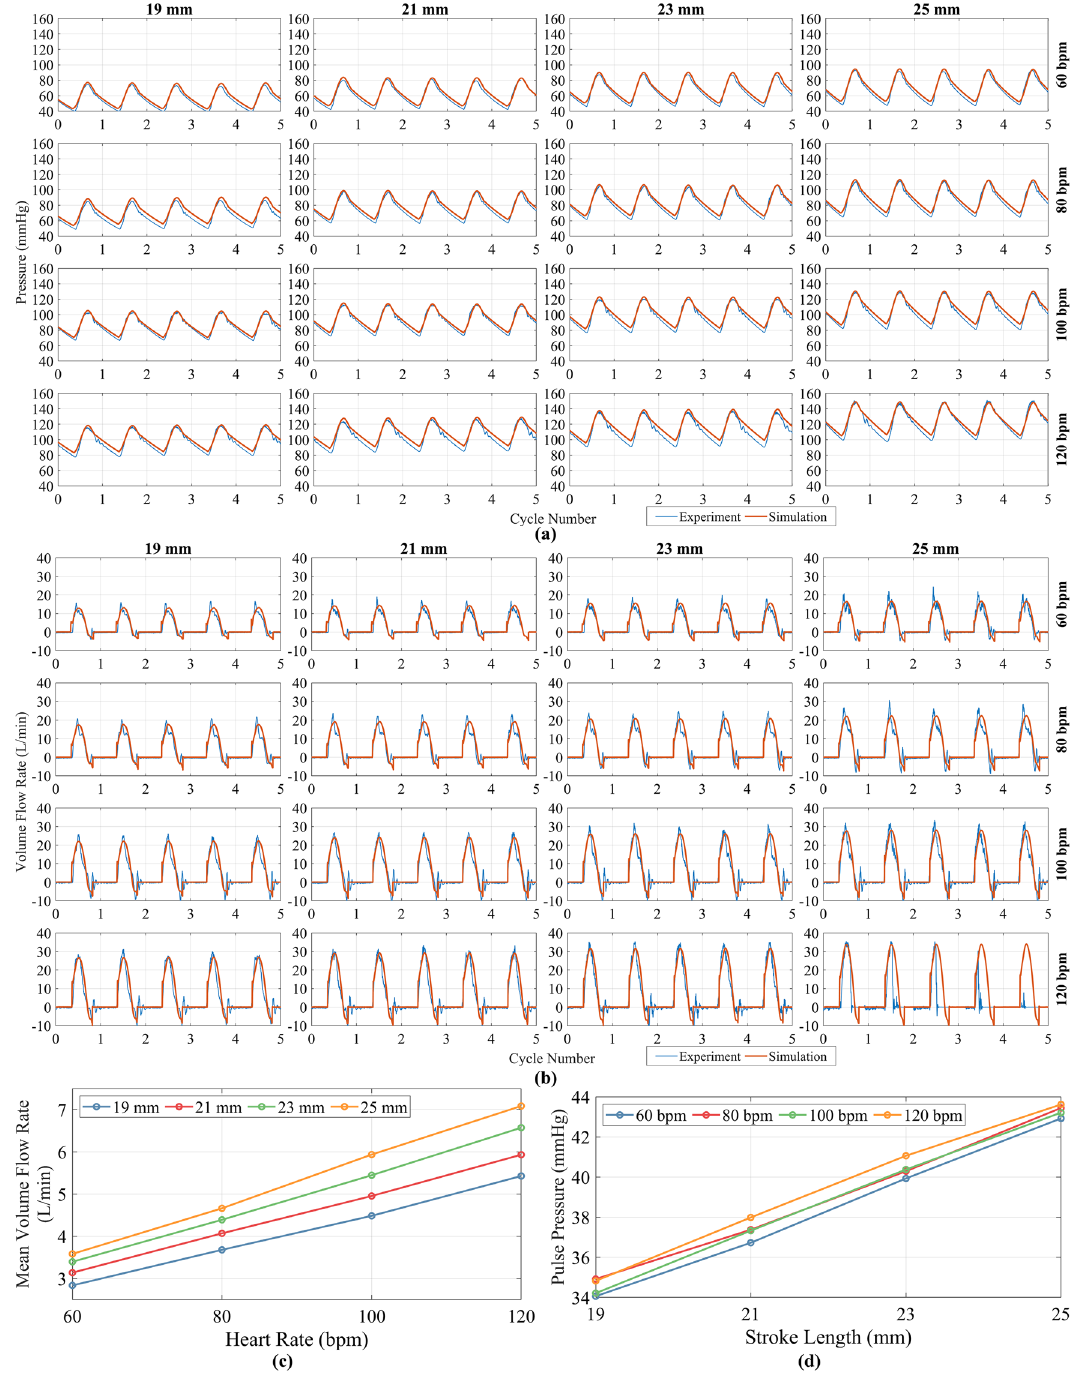
Figure 4. Comparison between simulated and experimental data from hybrid cardiovascular simulator of ( a ) outlet pressure and aortic pressure and ( b ) outlet volume flow rate and outflow volume flow rate showing good qualitative agreement between the sets of data. ( c ) Mean outlet volume flow rate against heart rate for a change in stroke length. ( d ) Outlet pulse pressure against stroke length with a change in heart